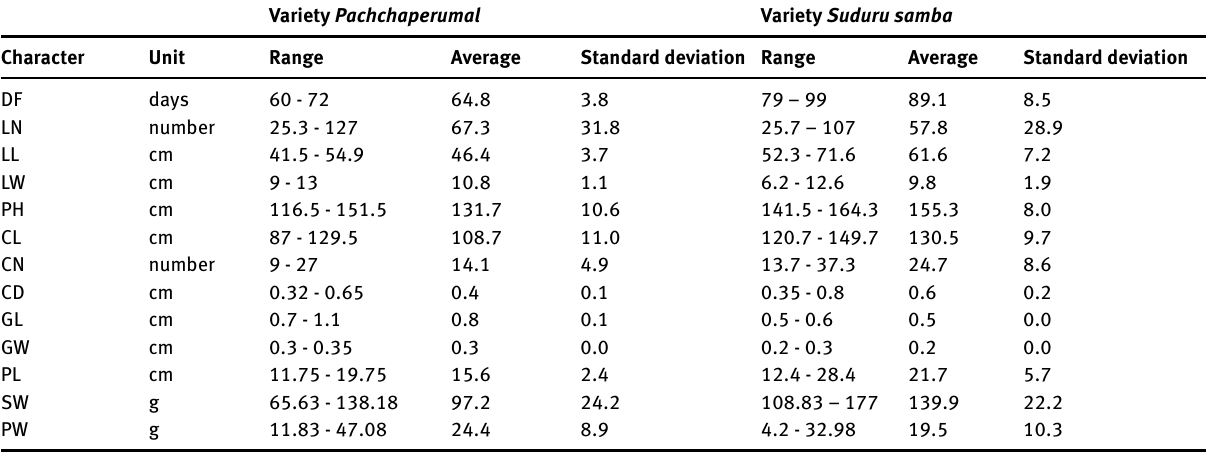
Table 1: Descriptive statistical explanation of the variation of quantitative characters among the accessions of Pachchaperumal and Suduru